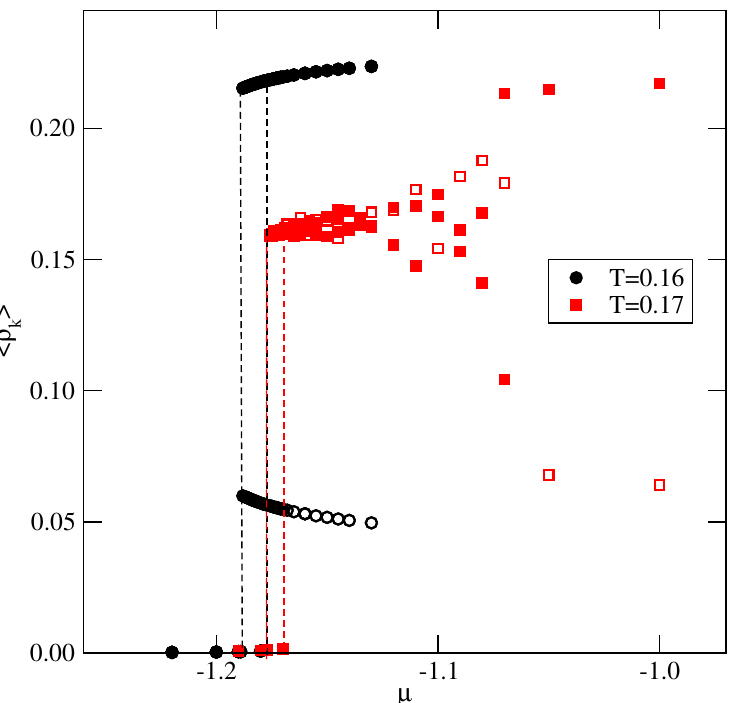
Figure 4. The densities of differently oriented particles along the isotherms obtained for the system with u ∗ = − 0.1 at two temperatures, given in the figure. The filled (open) symbols correspond to the four favored (the two disfavored) orientations in the ordered zigzag structure.